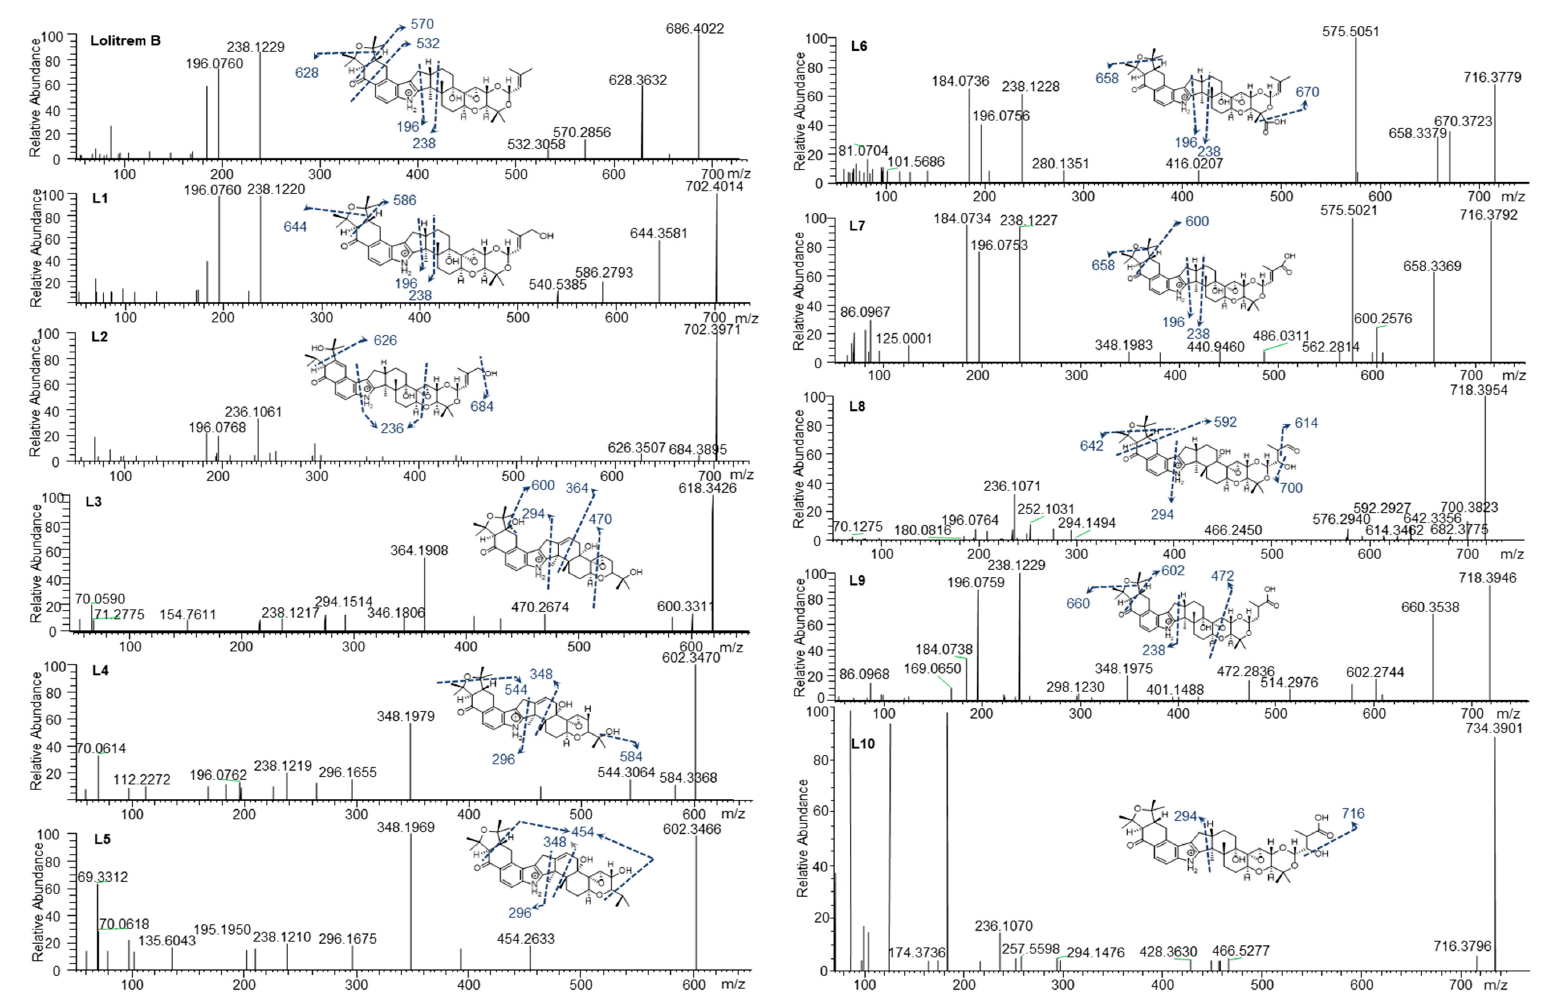
Figure 2. Lolitrem B, L1 to L10 MS 2 spectra and proposed structures and fragmentation pattern of the respective metabolites.